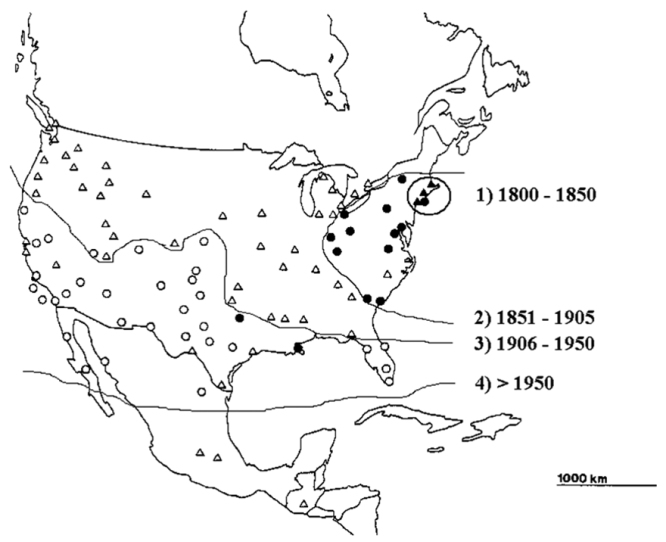
The expansion of Armadillidiumvulgare in North-America (modified after Garthwaite et al. 1995).